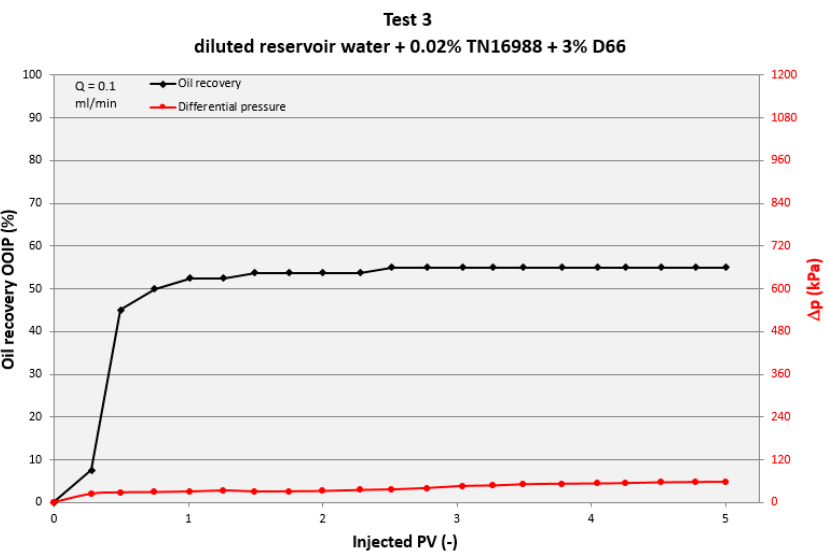
Figure 6. Recovery factor for diluted reservoir water with the addition of 0.02% polymer and 3% nanoemulsion.